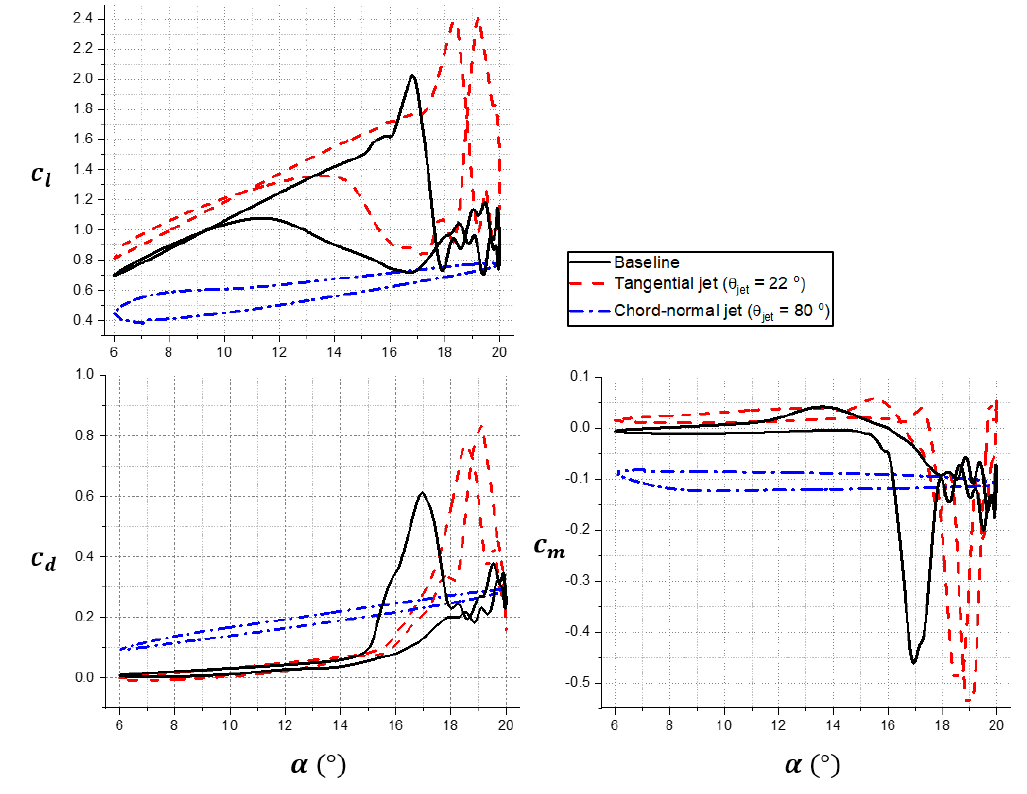
Figure 15. Pitching OA209 airfoil with and without steady-blowing jets. Ma = 0.3, Re = 1.15 M, c µ = 0.06, k = 0.05 and α = 13 ◦ ± 7 ◦